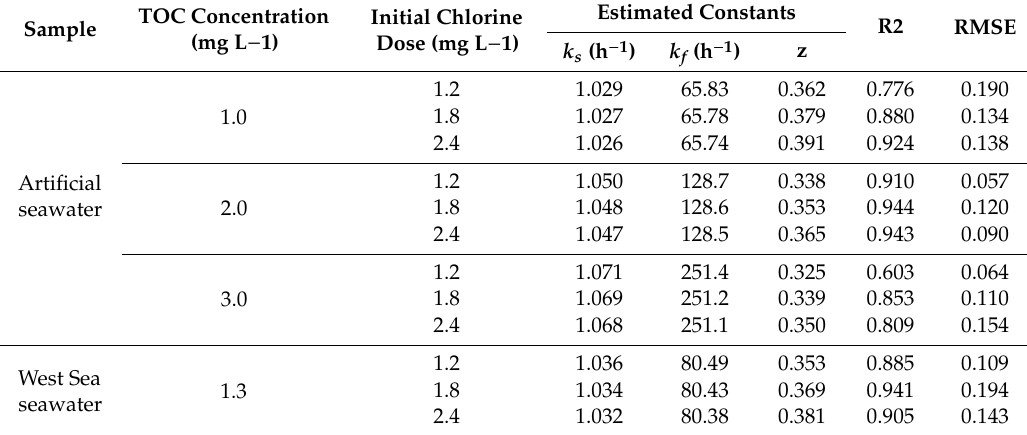
Table 1. Estimated kinetics parameters depending on total organic carbon (TOC) and initial chlorine dose. RMSE = root mean squared